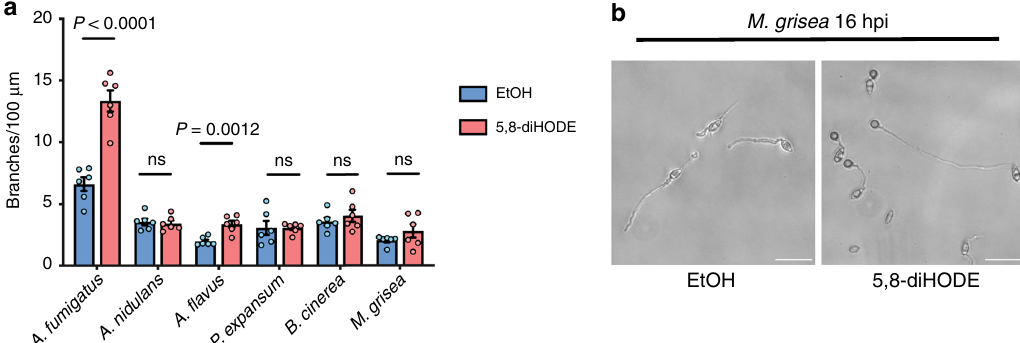
Fig. 4 Branching response of several fi lamentous fungal species that contain a PpoA ortholog. a Conidia of tested fungal species were inoculated in either GMM containing 1% EtOH or 5 µ g/mL 5,8-diHODE and incubated in 96-well plates ( n = 6). Six germinated hyphae were imaged via time-lapse microscopy for each treatment in each strain, and branching was assessed at speci fi c time points when both apical and lateral growth were evident. All cultures were incubated at the optimal and permissive temperature speci fi c to the species, and branching quanti fi cation was performed at a stage with pronounced apical growth and a signi fi cant degree of lateral branching. Multiple two-sided t tests were used to compare between treatment groups in each fungus. b Images of M. grisea cultures after exposure to either EtOH (1%) or 5 µ g/mL 5,8-diHODE for 16 h. Images are representative of six microscopic images acquired for each condition. Scale bar represents 20 µ m. All values represent mean ± SEM. ns not signi fi cant ( P > 0.05). A Aspergillus , P Penicillium , B Botrytis , M Magnaporthe